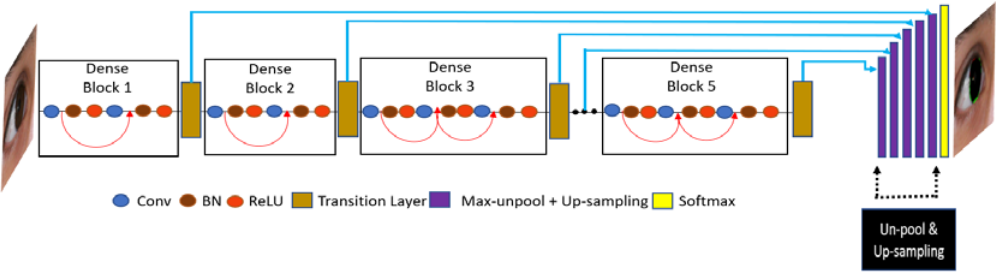
Figure 4. Overall connectivity diagram of IrisDenseNet dense encoder–decoder.